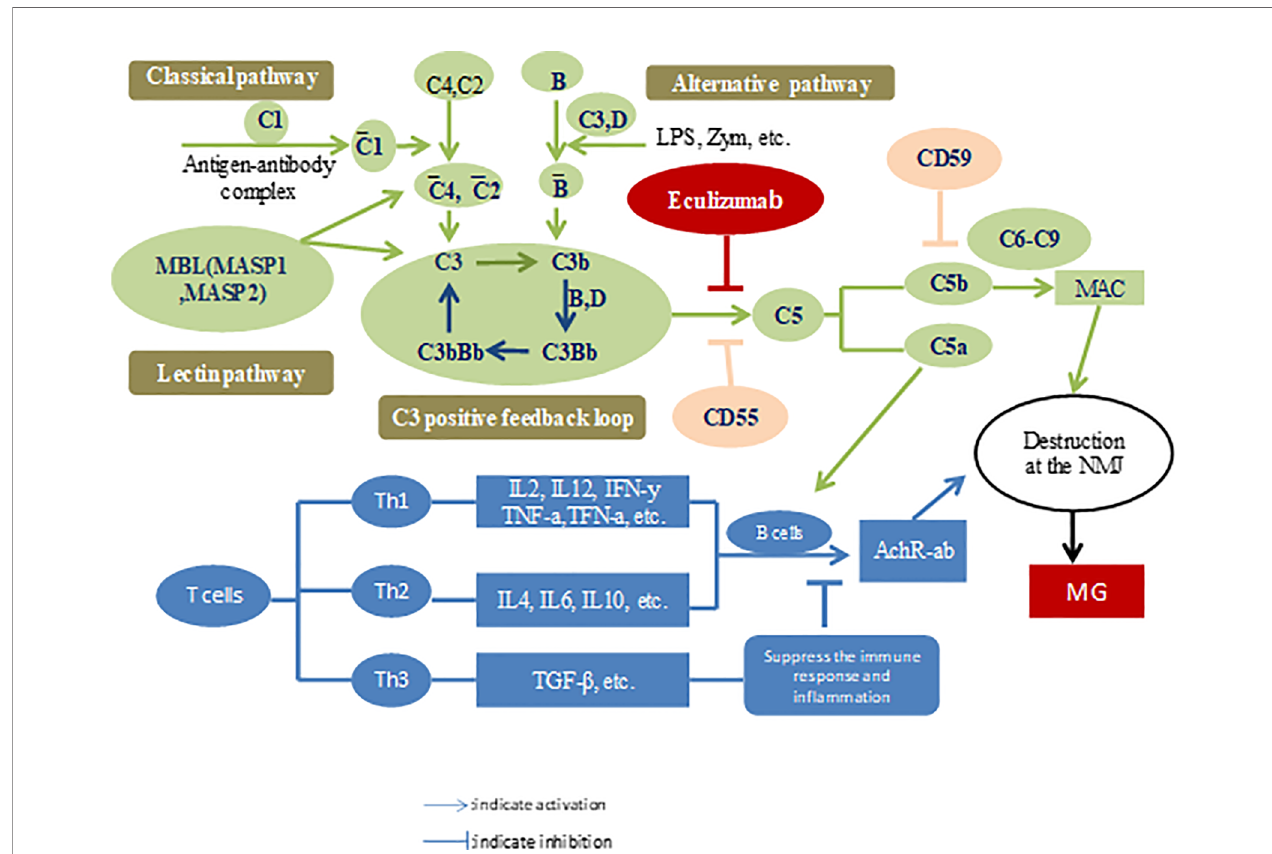
FIGURE 1 | Pharmaceutical effects of eculizumab for treating myasthenia